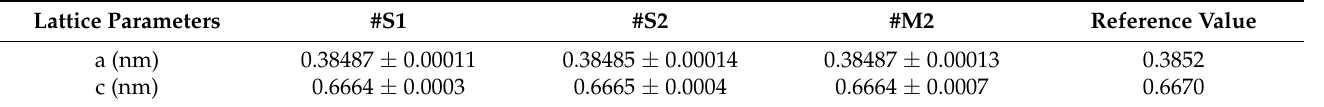
Table 2. Experimental lattice parameters of the hcp Gd 2 O 2 S compound as estimated from peak shape analysis of XRD patterns. Nominal values are reported for